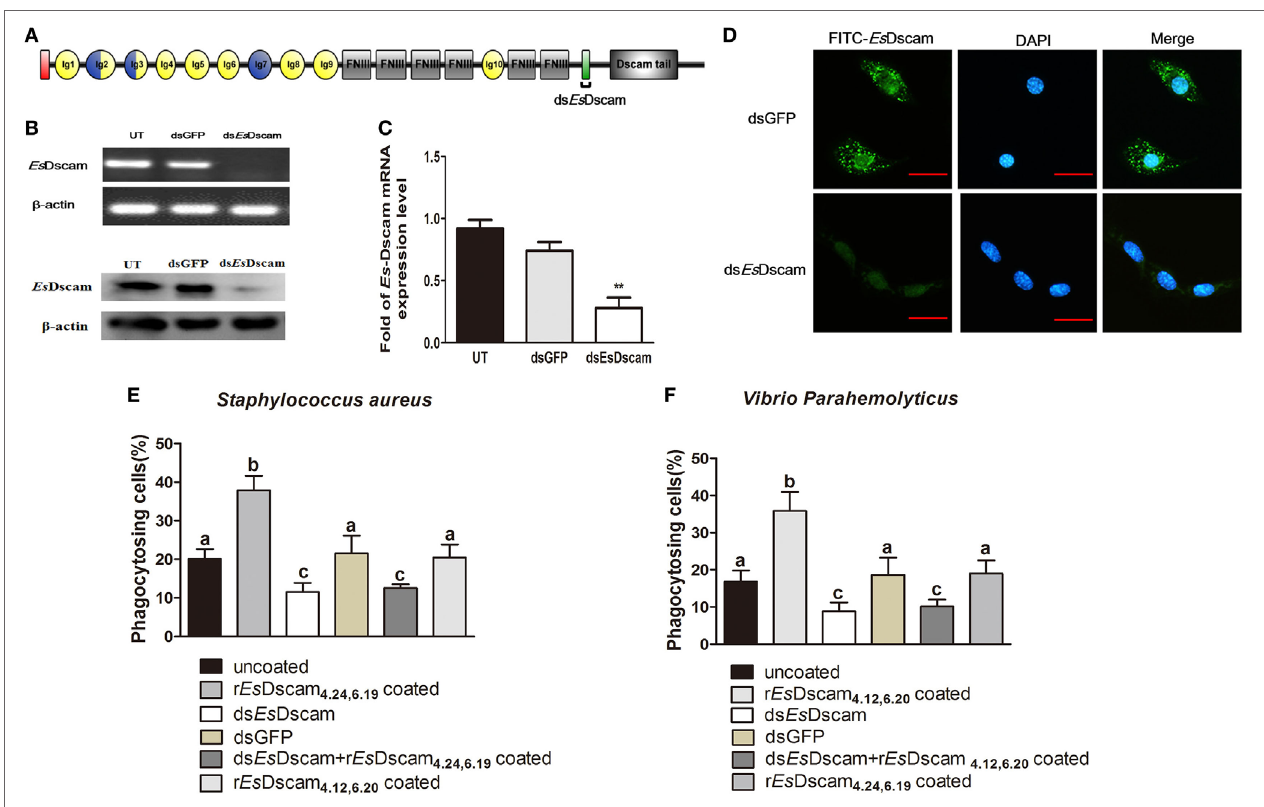
FigUre 7 | Soluble Es Dscam promotes phagocytosis via membrane-bound Es Dscam in hemocytes. (a) Schematic diagram showing the RNAi region recognized by primers in the conserved transmembrane region of ds Es Dscam. (B–D) Knockdown of Es Dscam expression. Crab hemnocyte were transfected with Es Dscam dsRNA (5 nM) and equal amounts of GFP dsRNA served as a control. RNA samples were collected at 24 h post-transfection to check the silencing efficiency by RT-PCR ( left panel ) and qRT-PCR ( right panel ) with β -actin as a reference. And the protein samples also were collected and detected by Western blotting with β -actin as a reference. RT-PCR data are representative of two independent repeats. At least three crab were used for each sample, and qRT-PCR were performed three times. The results are expressed as the mean ± SD, data were analyzed by Student’s t -test. ** p < 0.01. ( Right panel ) Immunocytochemical analysis of Es Dscam dsRNA transfected hemocyte showing decreased Es Dscam protein expression compared with dsGFP-treated control cells. Scale bar = 15 µm. Data are representative of three independent repeats. (e,F) Membrane-bound Es Dscam regulate soluble Es Dscam promoted phagocytosis in hemocyte. Rate of hemocyte phagocytosis of (e) Staphylococcus aureus and (F) Vibrio parahemolyticus following Es Dscam knockdown. Phagocytic rates of hemocytes were calculated according to the formula presented in the Materials and Methods section. Three independent repeats were performed, and results are expressed as the mean ± SD. Data were analyzed by one-way ANOVA and the letters (a, b, c) presented significant differences ( p <